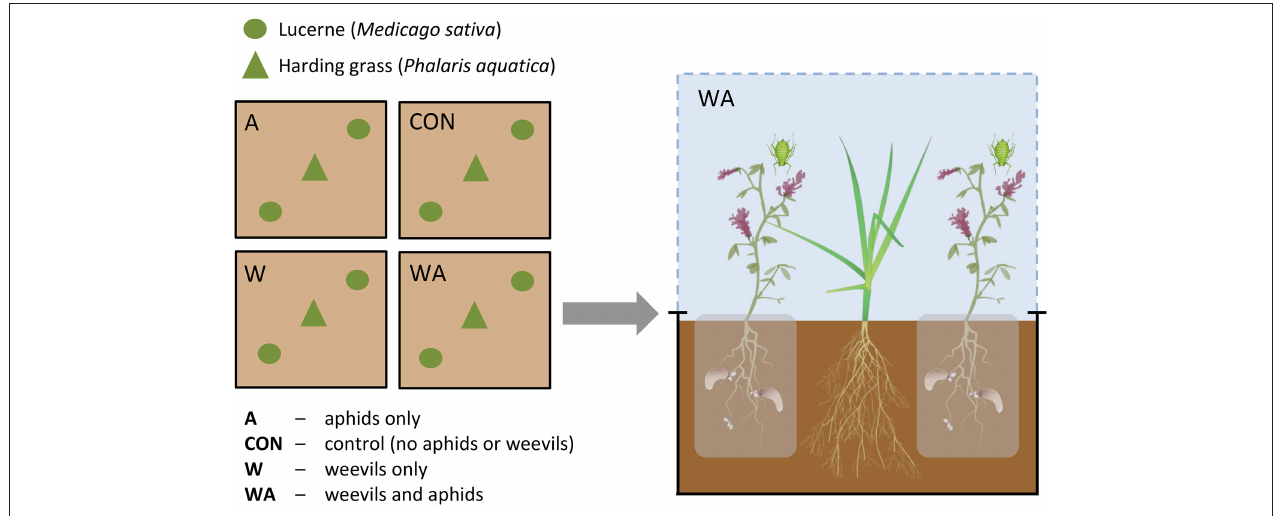
FIGURE 1 | Schematic diagram of experimental plots beneath one rain-exclusion shelter.